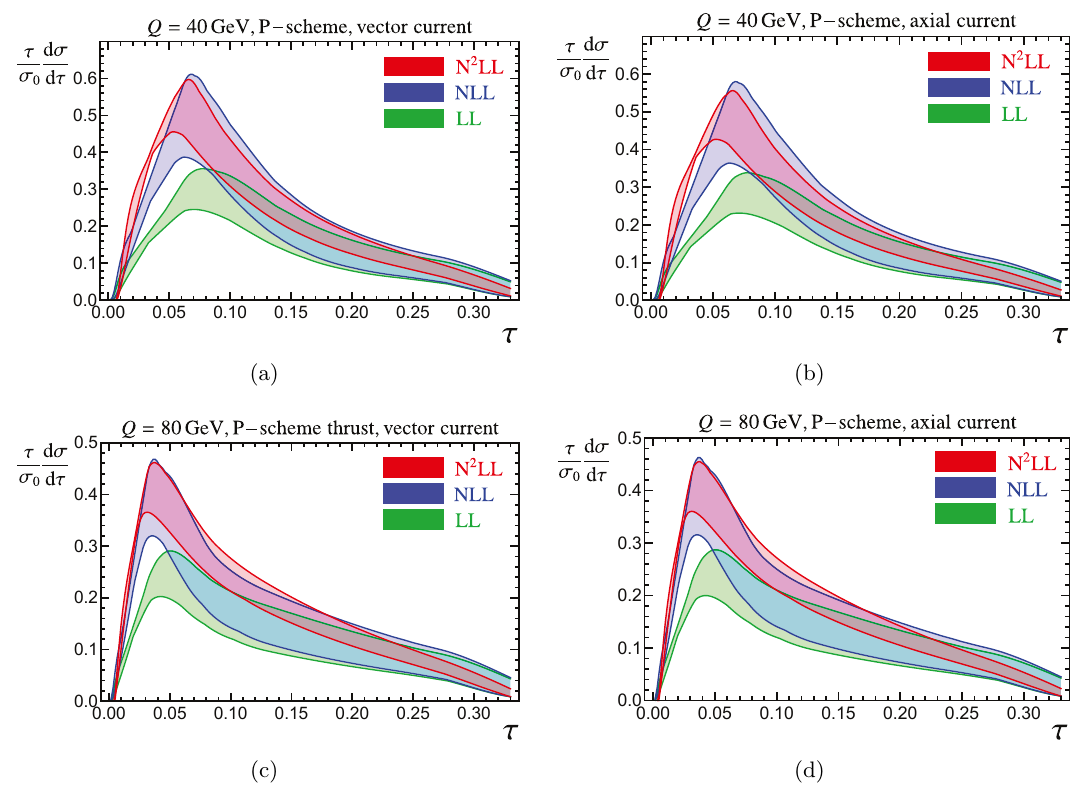
Figure 8 . Uncertainty bands for LL (green), NLL (blue) and N 2 LL (red) for P-scheme thrust cross sections at 40 GeV ((cid:12)gures on top) and 80 GeV ((cid:12)gures at the bottom), for vector (left (cid:12)gures) and axial-vector (right (cid:12)gures) currents. The bands are obtained with 500 pro(cid:12)les generated randomly selecting values for the parameters that de(cid:12)ne